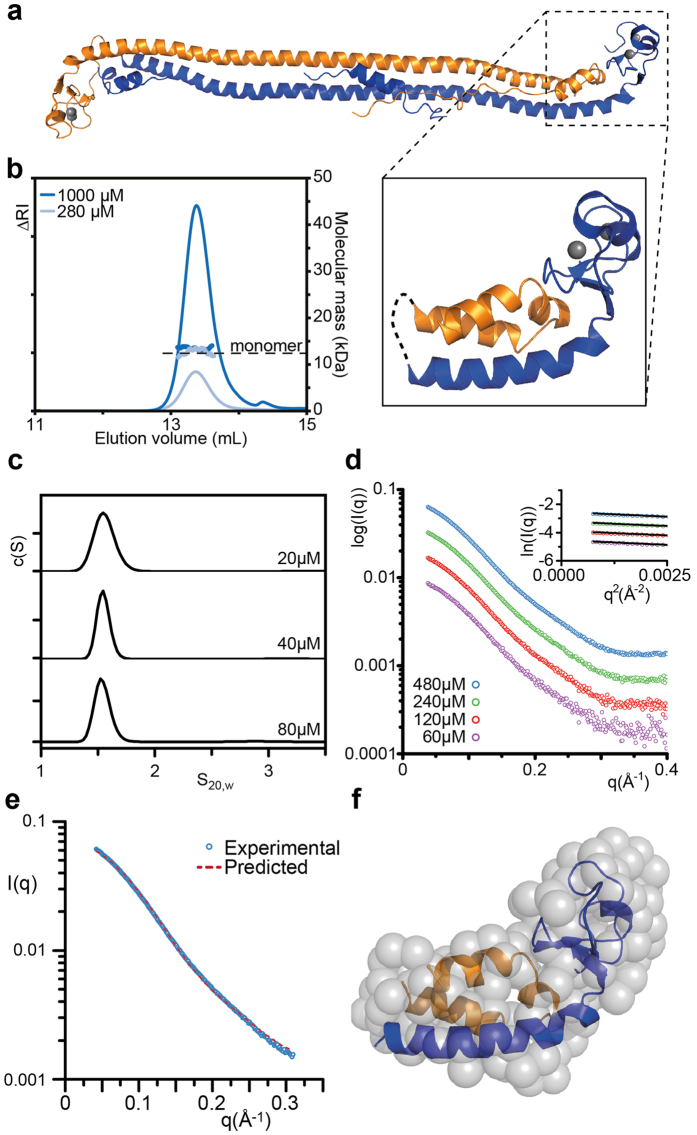
The Bbox and elements of the coiled-coil fold as a single domain.Design and characterization of RhT5α 88–261dCC EK/RD. (a) Structure of the Bbox-coiled-coil region from Trim5α (PDB id:4TN317) Predicted structure of RhT5 88–261dCC with designed linker shown as dashed line is shown inset. Residues from monomer A are coloured blue and monomer B are coloured orange. Zinc atoms are shown as grey spheres. (b) SEC-MALLS analysis. Chromatogram from the differential refractive index detector are shown at two protein concentrations. Mw measured across the peak corresponding to a monomeric species is shown as open circles. (c) Sedimentation velocity AUC c(S) analysis at three protein concentrations. (d) SAXS curves between 60–480 μM with inset guinier analysis. (e) Comparison of SAXS scattering at 480 μM (6 mg/ml) to predicted model shown in (a). (f) ab initio bead model from SAXS generated in GASBOR compared to the predicted model shown in (a).